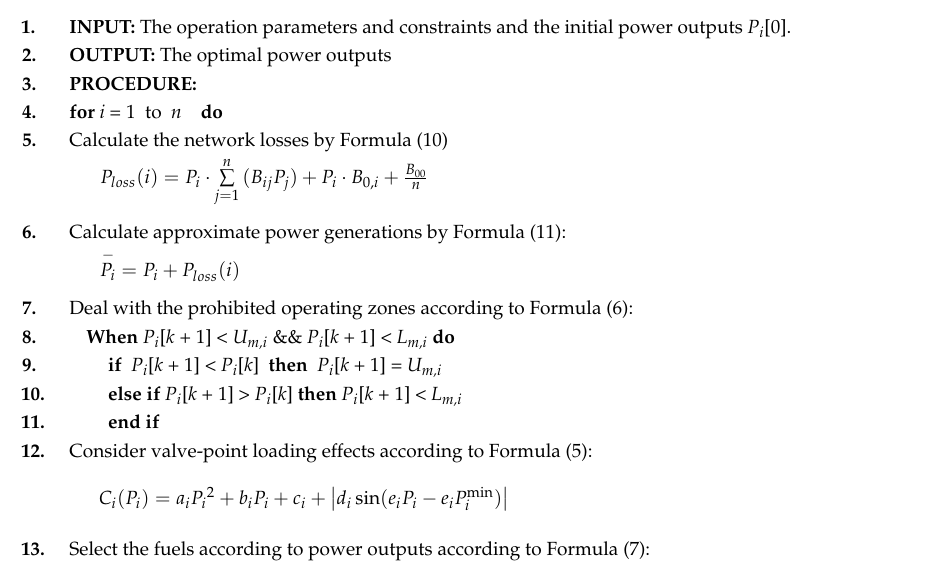
Algorithm 1: the distributed randomized gradient-free algorithm for non-convex economic dispatch